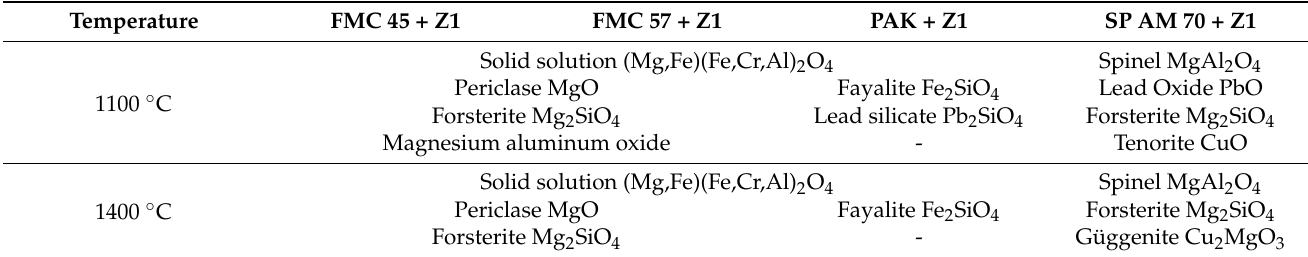
Table 5. Phases present in raw material–slag mixtures, after pellet test at 1100 ◦ C and 1400 ◦ C.